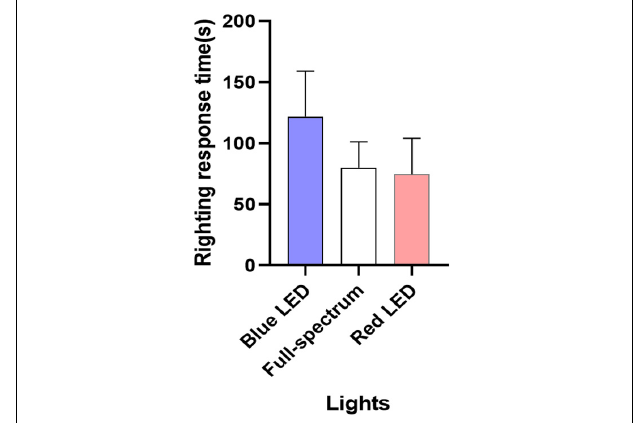
FIGURE 5 | The numbers of blue, red, and transparent acrylic sheets gripped by T. gratilla under different wavelength LED illumination. Each value represents mean ± SD.